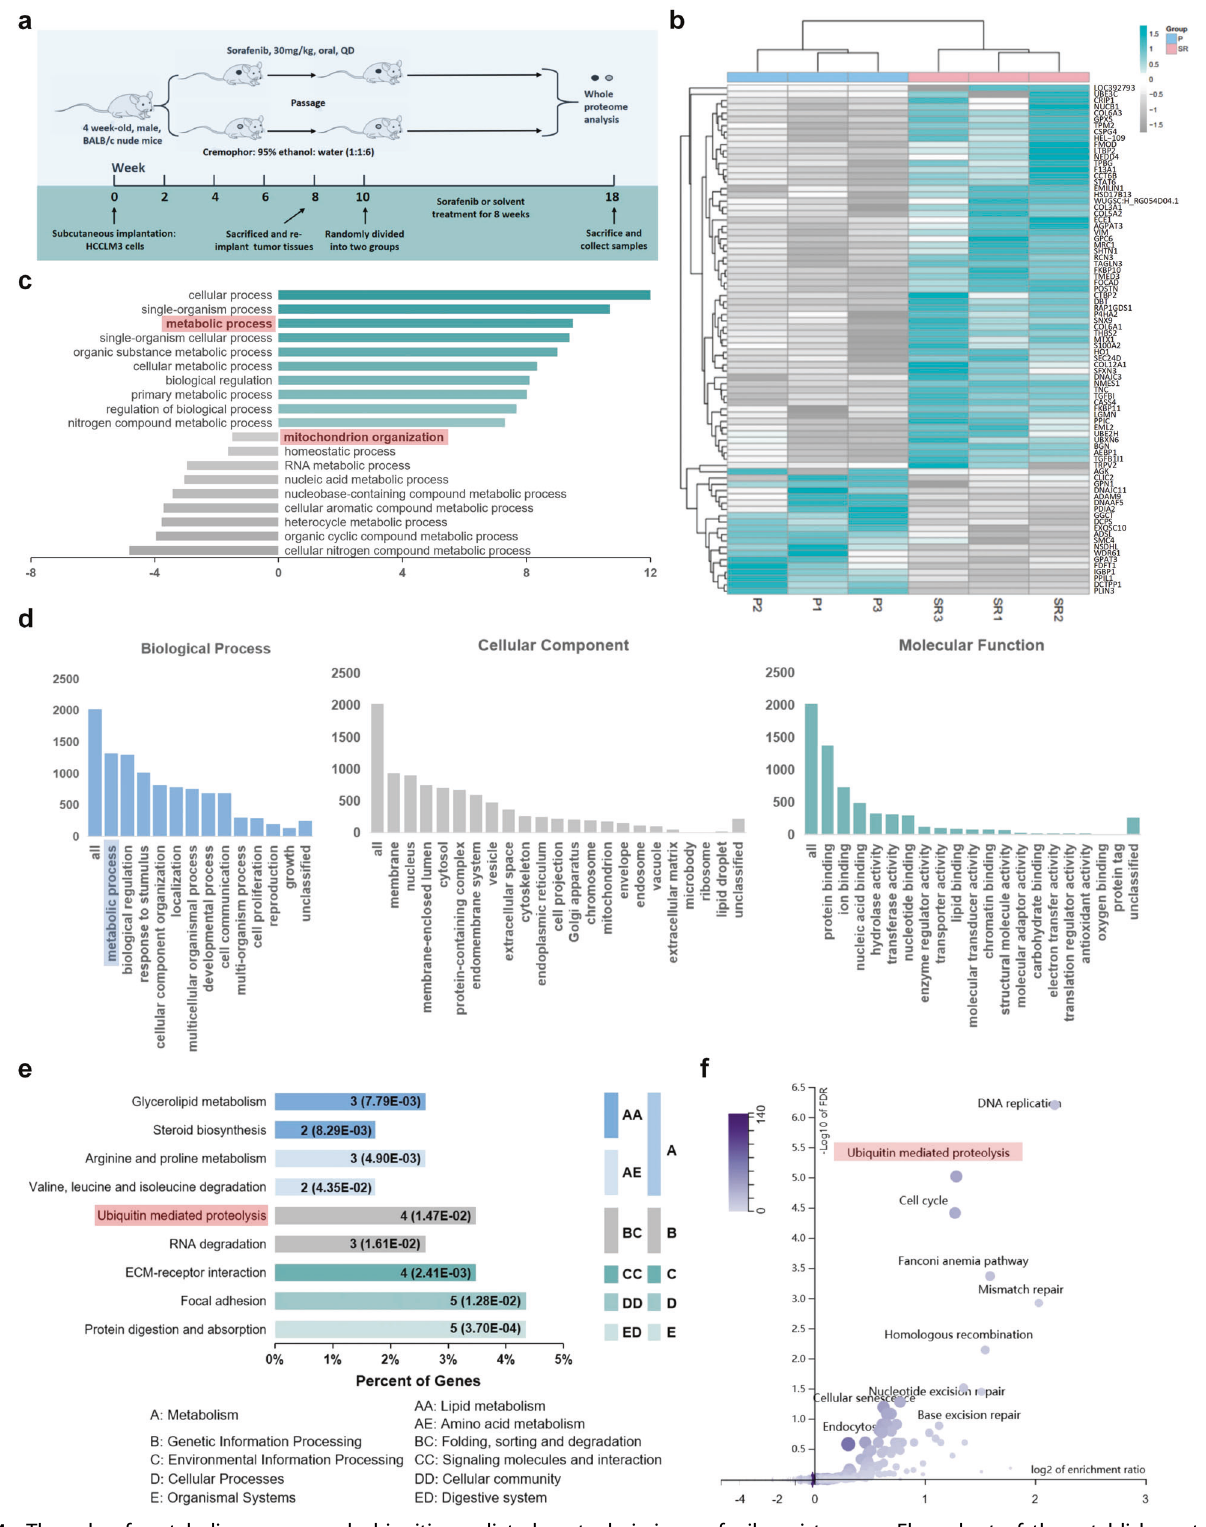
Fig. 4 The role of metabolic process and ubiquitin-mediated proteolysis in sorafenib resistance. a Flow chart of the establishment of a orthotopic sorafenib-resistant mouse model. b The heatmap shows 80 proteins identi fi ed via mass spectrum analysis, with differential expressions ( p < 0.05) between tumors harvested from the parental and sorafenib-resistant models described in a . P parental, SR sorafenib- resistant. c GO analysis of the deregulated proteins shown in b indicated that metabolic process and mitochondrion organization were changed in resistant cells ( p = 0.0105). d GO analysis using GSE94550 from GEO datasets. Biological process, cellular component, and molecular function category were represented. e KEGG pathway analysis of the deregulated proteins shown in b indicated that the ubiquitin – proteasome pathway was altered in sorafenib-resistant cells ( p = 0.0147). f KEGG pathway analysis using GSE94550 from GEO datasets demonstrated that ubiquitin-mediated proteolysis was involved in resistance development ( p = 5.9138e − 8) Signal Transduction and Targeted Therapy (2021)